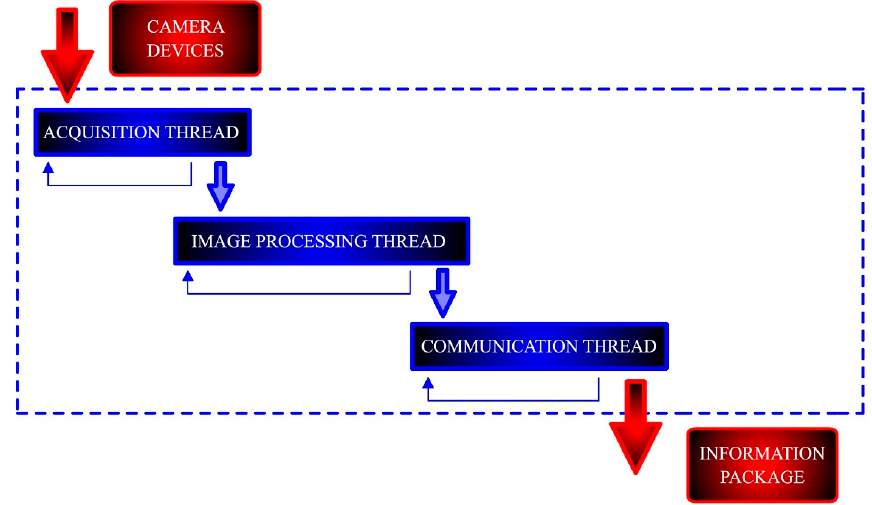
Figure 2. Implementation architecture for machine vision. Three different threads running in